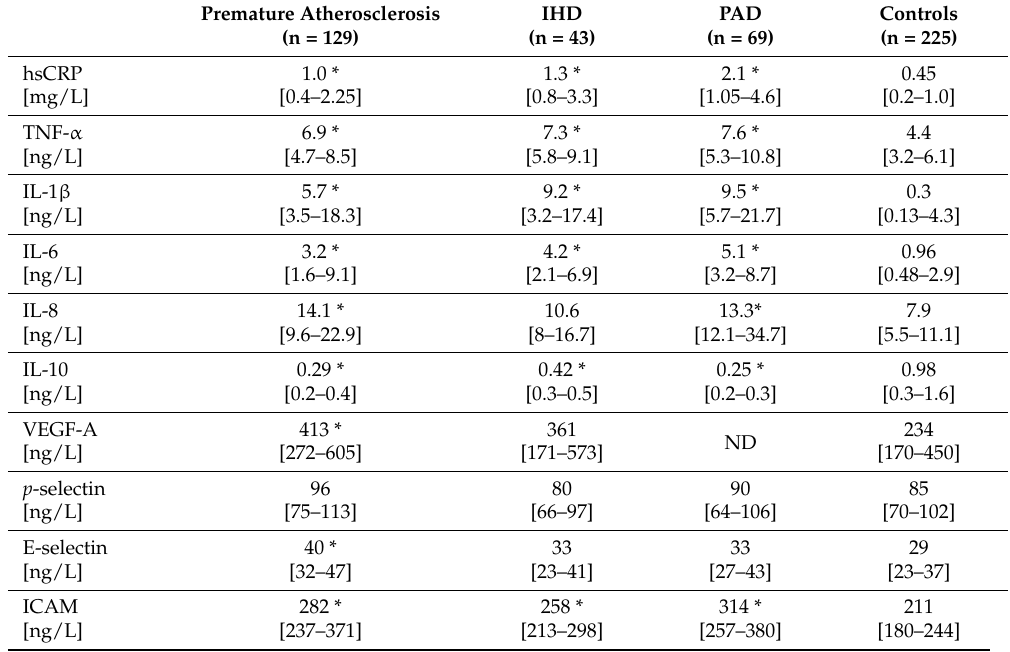
Table 7. Relationship between serum bilirubin concentration and hsCRP and proinflammatory cytokines in patients with atherosclerosis.